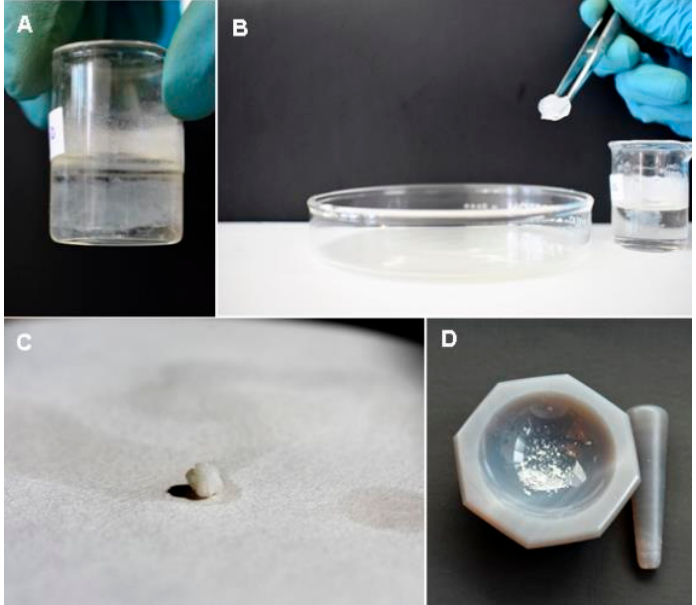
Figure 2. Process of separation of the bioconjugate of oleic acid and L. cysteine: ( A ) Formation of a gel at pH 12, ( B ) Physical extraction of the gel, ( C ) Drying, and ( D ) Crushing of the sample.